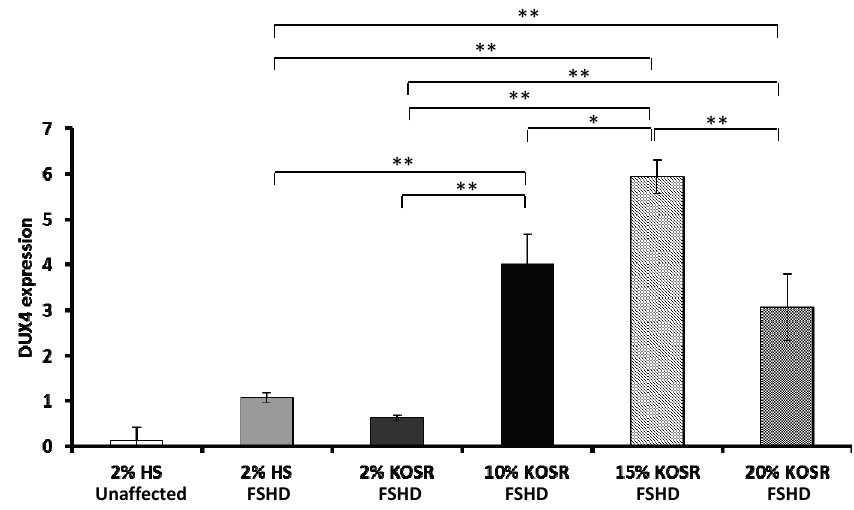
Figure 5. Concentration-dependent increase of DUX4 in differentiated FSHD myotubes in response to KOSR. Immortalized FSHD myoblasts were differentiated in media with 2% HS, 2% KOSR, 10% KOSR, 15% KOSR, and 20% KOSR, respectively. The mRNA expression of DUX4 were quantified using qRT-PCR. CON, control; * p < 0.05; ** p <